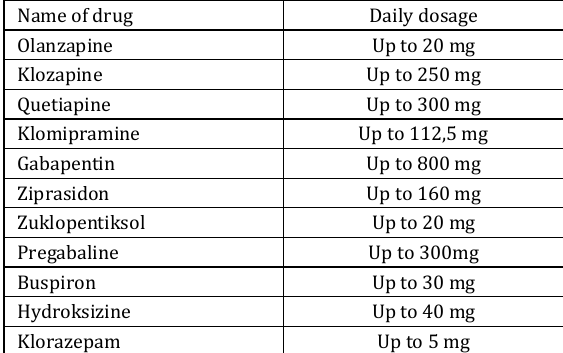
Table 2. Daily dosages of